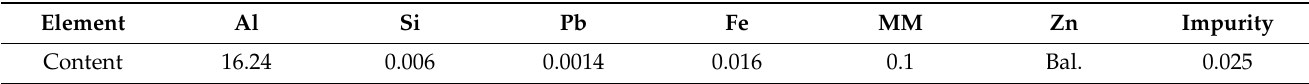
Table 3. Chemical composition of zinc and aluminum ingots (wt%).